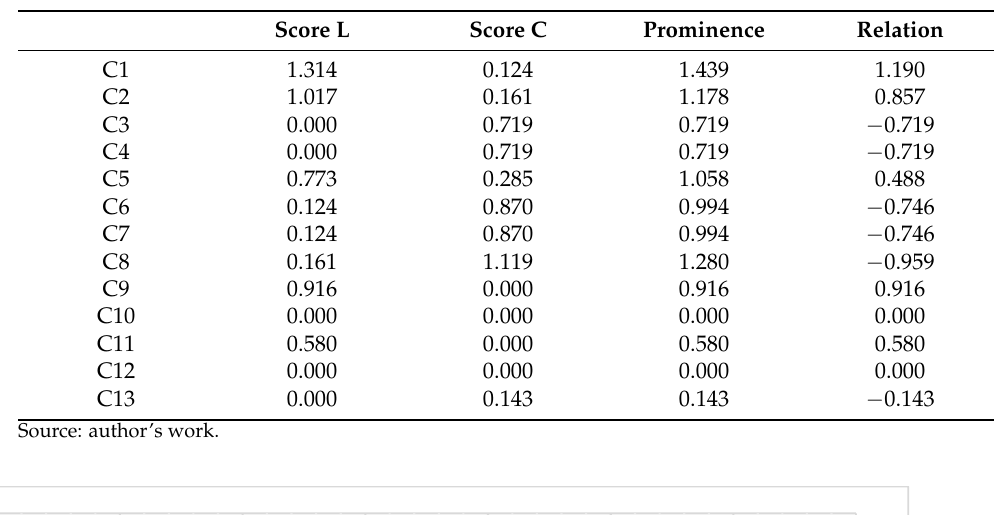
Table 7. The value of the position indicator and relation indicator (DEMATEL method).